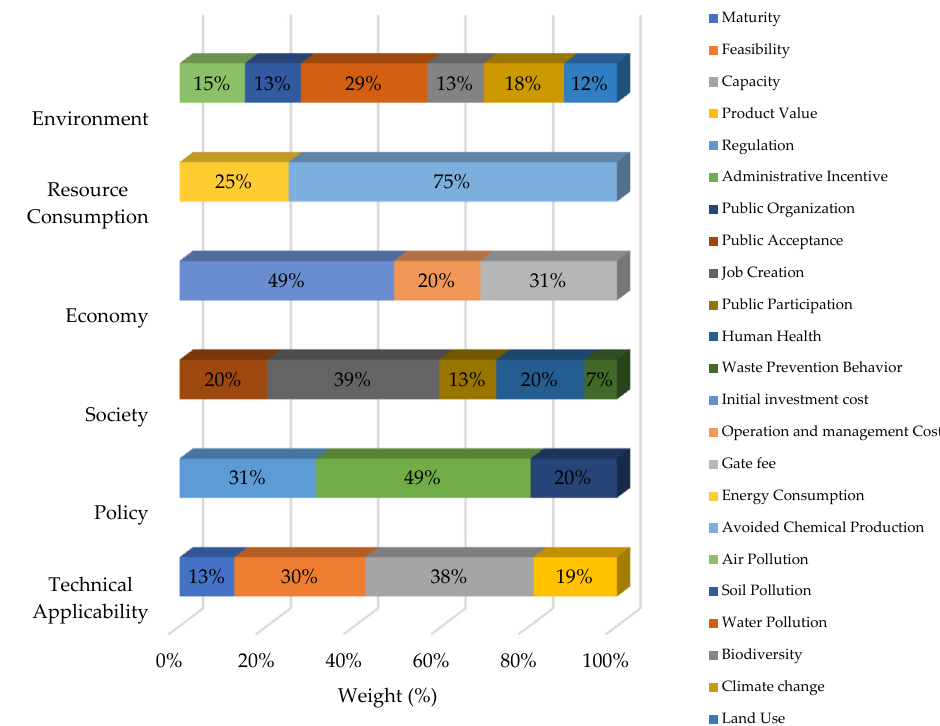
Figure 4. Sub-criteria priority (%).